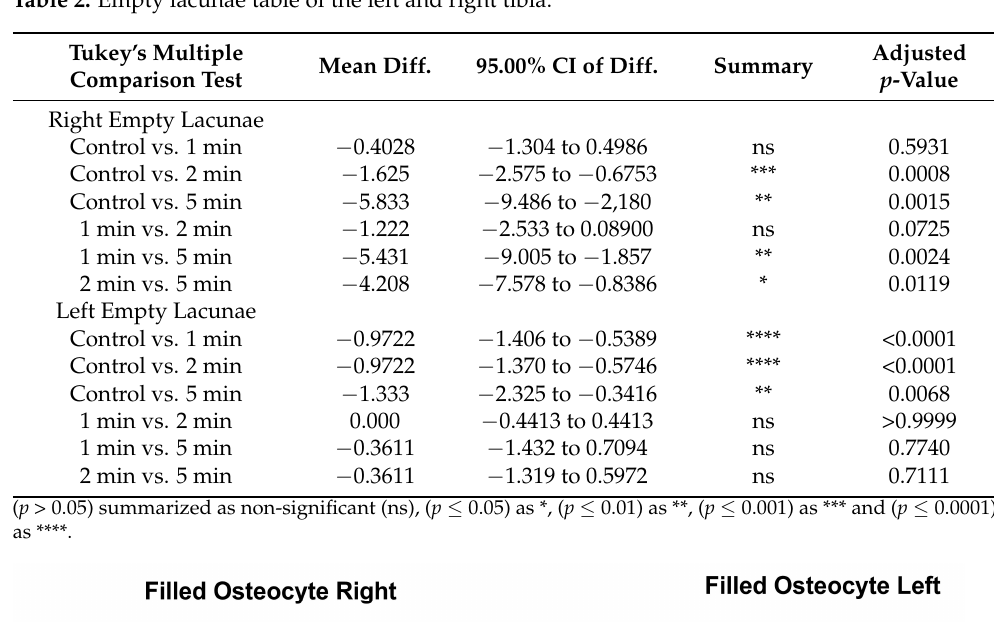
Table 2. Empty lacunae table of the left and right tibia.